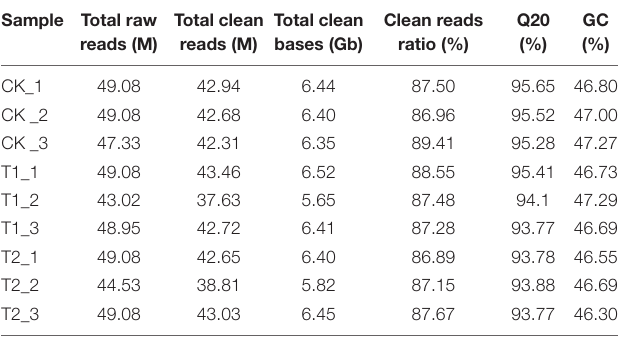
TABLE 1 | Summary of RNA-sequencing data under drought